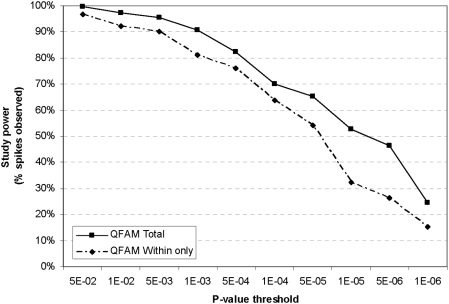
Inclusion of a between-family test of association increases study power using p-value as a metric.A known effect comprising 2% of phenotypic variance explained was “spiked” into a dataset of 770 randomly selected SNPs with MAF≥0.01. Study power was evaluated for within-only (PLINK/QFAM-Within) and within- and between-family (PLINK/QFAM-Total) tests of association. After calibrating the score distribution to the null using genomic control, study power is measured as the fraction of datasets in which the “spiked” SNP exceeds a particular p-value threshold.